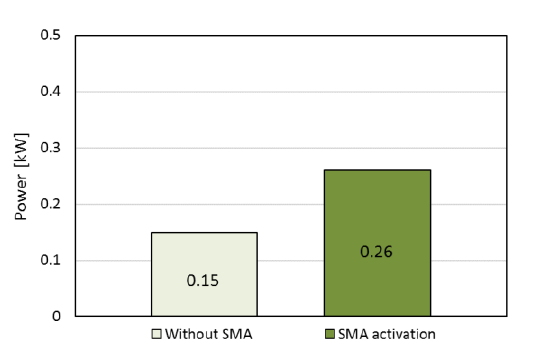
Fig. 17. Harmonics of the power required for hovering – II h power pulsa- tion